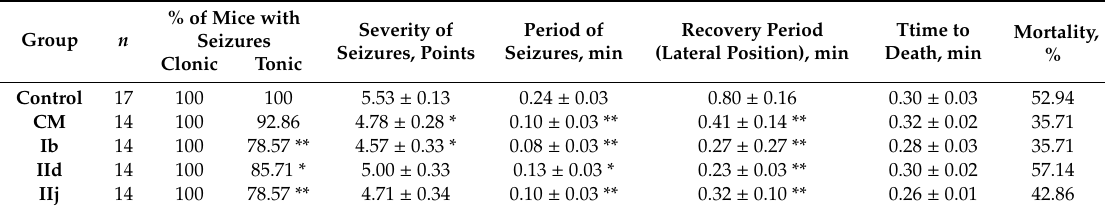
Table 2. Anticonvulsant e ff ect of tested compounds in MES